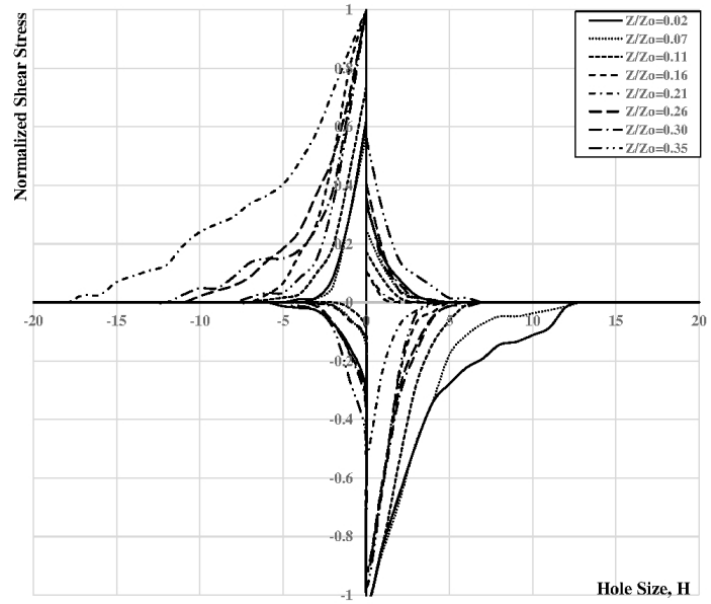
Figure 6. Quadrant analysis close to the toe of the weir (x = 2.45 m from origin of the flume).